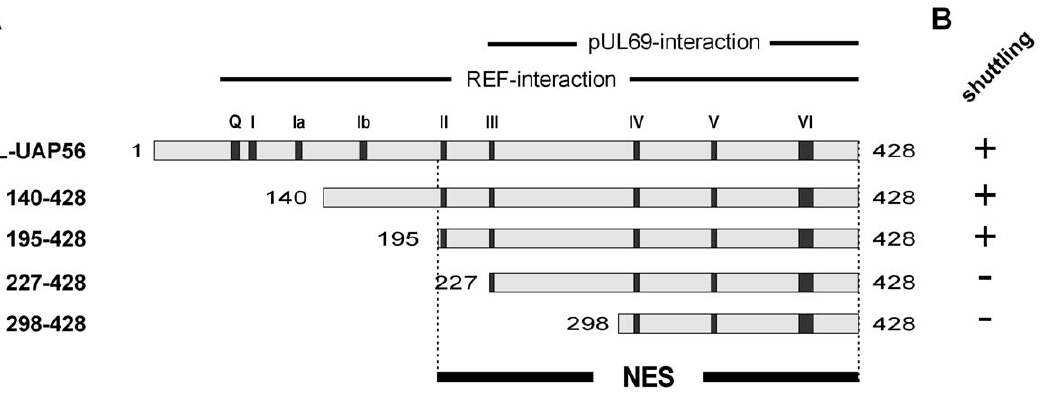
Figure 7. Delineation of the putative NES within the C-terminus of UAP56 by heterokaryon analysis. (A) Deletion mutagenesis of UAP56 was performed to construct the UAP56 mutants indicated in panel A. Highlighted by bars: pUL69-interaction motif (aa227-428); REF-interaction motif (aa81-428); NES, nuclear export signal (aa195-428). (B) The constructs shown in panel A were tested by heterokaryon analyses for their ability to shuttle from the nucleus of a transfected HeLa cell to a murine nucleus. Positive staining of the murine nucleus is indicated by ‘ + ’, no staining is indicated by a ‘-‘.